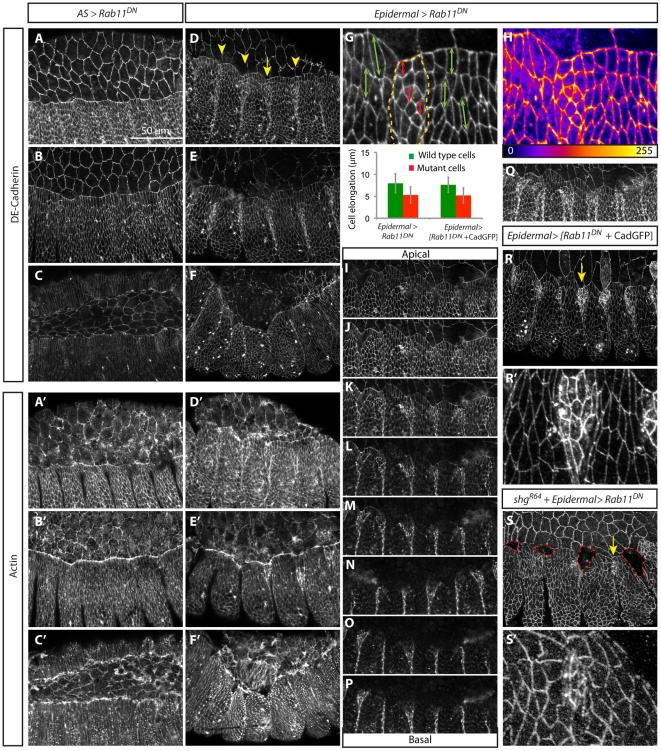
Rab11DN expression impairs epidermal advancement and mislocalizes DE-Cadherin.Confocal sections from Drosophila embryos expressing Rab11DN immunostained with DE-Cadherin (A–Q, R–S') and phalloidin to visualize F-actin (A'–F'). Three different stages of DC are shown (A–F'). At early stages, AS cells expressing Rab11DN do not exhibit wavy membranes as in the wild type (A). Expression of Rab11DN does not impair epidermal cell elongation (B), but zippering is deffective (C). DE-Cadherin levels (A–C) and Actin distribution (A'–C') in the AS are not affected. Embryos expressing Rab11DN in the engrailed domain show a delay in the advancement of the dorsal epidermal cells and are less elongated (D, arrowheads). Later embryos exhibit ectopic grooves in the Rab11DN domain of expression (E) and zippering does not occur (F). Actin accumulates at the LE in the DME cells expressing Rab11DN (E'). Epidermal cell elongation in Rab11DN expressing cells and wild type cells (H-yellow dashed line outline Rab11DN domain of expression) and quantification of cell elongation of DME cells in the D/V direction in wild type cells (green) and Rab11DN expressing cells (red) in Epidermal > Rab11DN embryos (G - Magnification from D). Cell elongation is significantly reduced in Rab11DN expressing cells [p<0.01 (N = 234 and 145 (G)]. In the mutant cells the levels of DE-Cadherin are higher at the cell membrane and in the cytoplasm of epidermal cells (H - Magnification from D, gradient represents fluorescence intensity values). DE-Cadherin is dispersed along the A/P axis in epidermal cells where Rab11DN is expressed (I-P). Projection of sections I-P (Q). Overexpression and reduction of DE-Cadherin in embryos expressing Rab11DN in epidermal stripes (R-S'). Epidermal cells expressing Rab11DN and CadherinGFP exhibit a delay in epidermal advancement and impaired cell elongation similar to embryos expressing Rab11DN alone in epidermal stripes [R, R', G (N = 129 and 69)]. In shgR64 mutants (reduction of DE-Cadherin levels) epidermal cells expressing Rab11DN do not elongate and detach from the AS (S, red dashed line outlines the holes). The levels of DE-Cadherin at the cell membrane are higher in the region where Rab11DN is expressed (R', S').